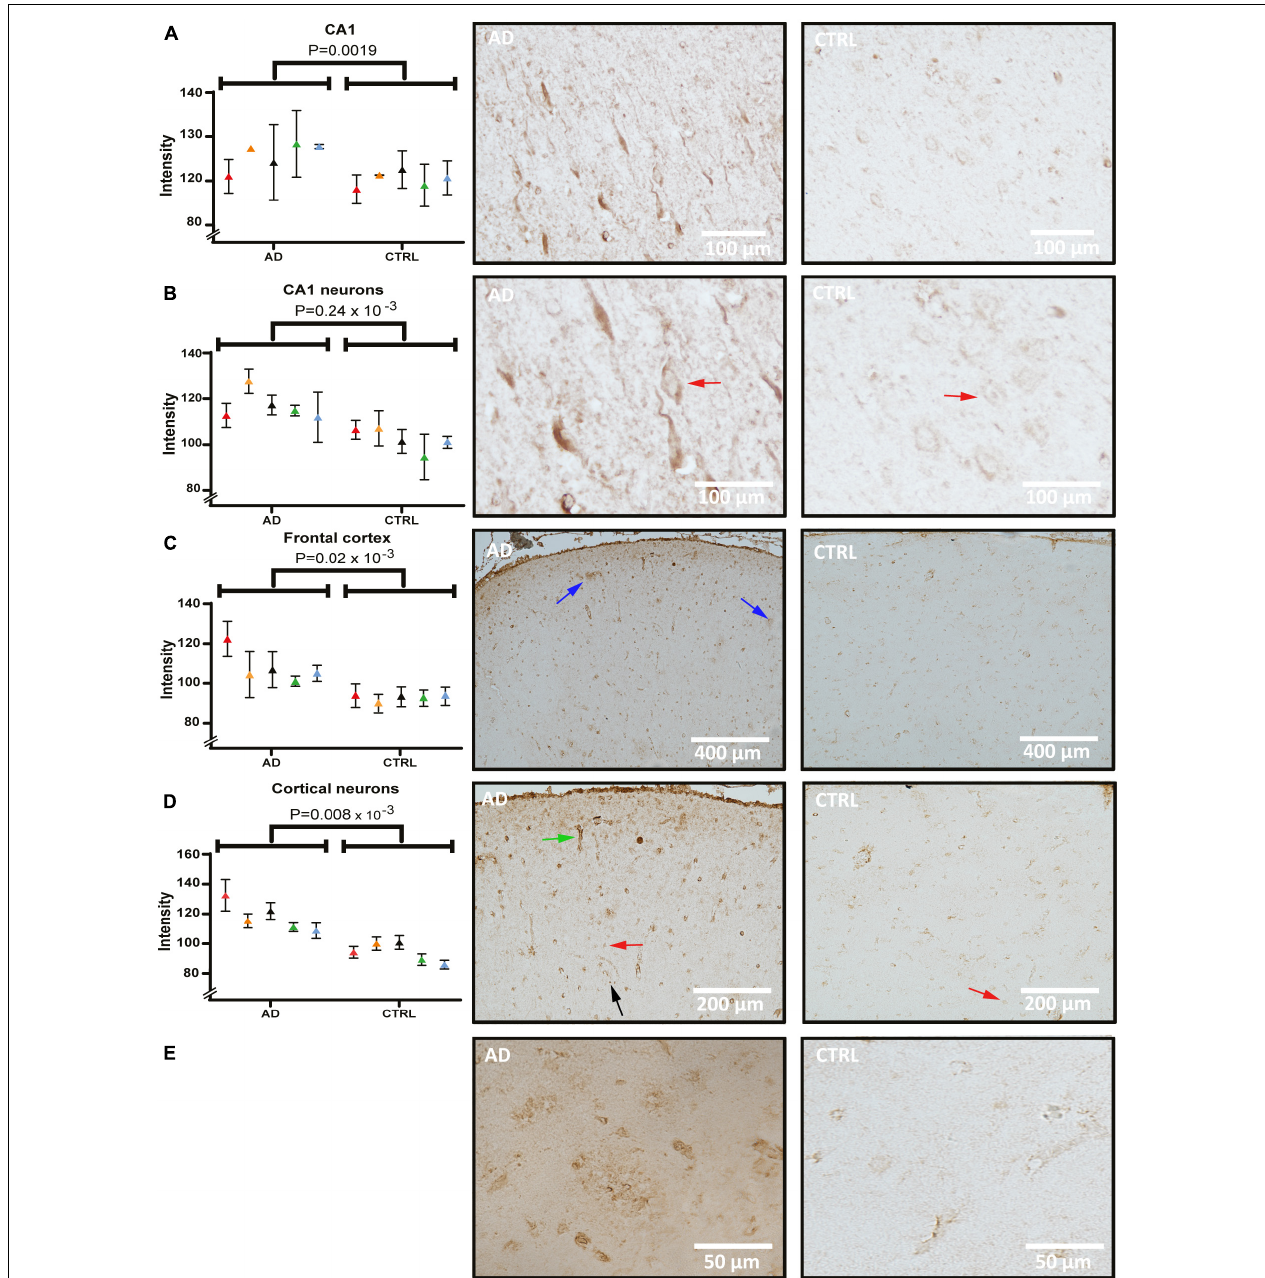
FIGURE 3 | Creatine kinase B (CKB) levels and distribution in the hippocampus and frontal cortex of AD and control. Panel (A) shows quantification and brightfield images of CKB in the CA1 subfield of AD and control. Panel (B) shows quantification and analysis of CA1 pyramidal cellular soma of AD and control. Panel (C) shows quantification and images from the frontal cortex and panel (D) quantification and images of pyramidal cellular staining in the frontal cortex. Individual patients are indicated by colors in the graphs. Examples of pyramidal cells and glial cells are indicated by red and black arrows, respectively. CKB deposits within the frontal cortex were seen occasionally and is indicated by blue arrows in panel C and in magnified pictures from AD and control in panel (E) . Example of vascular staining that was seen in AD is indicated by a green arrow. AD, Alzheimer’s